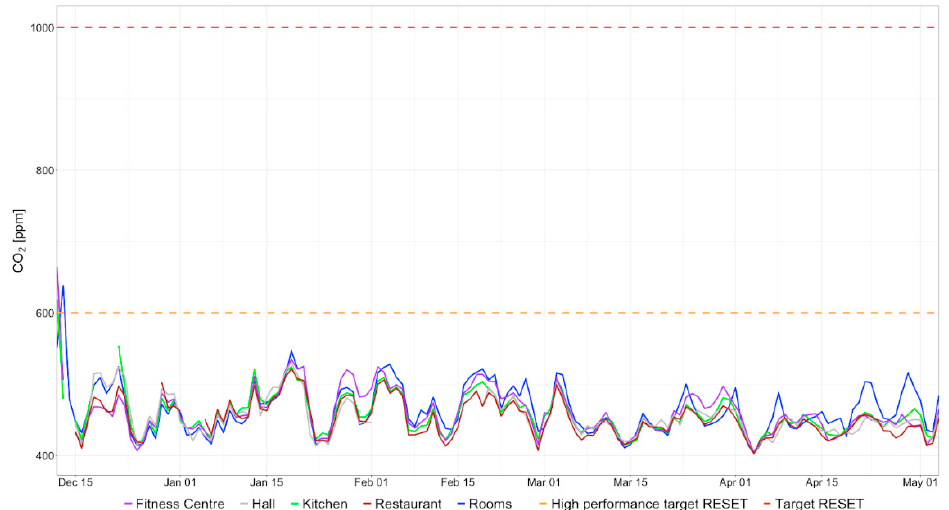
Table 4. Descriptive statistics for the different contaminants monitored, in each environment in- cluded.